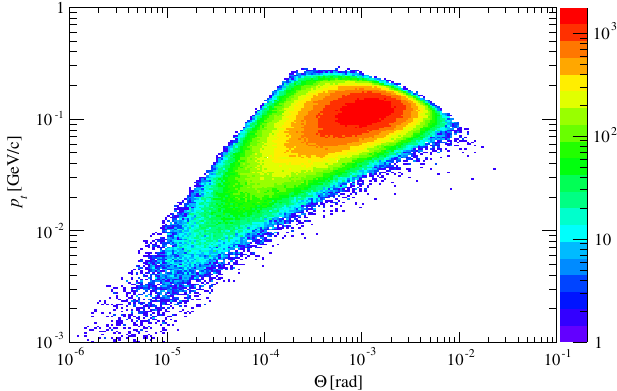
FIG. 11. Distribution of same-charge (defocused) direct tridents after one bunch crossing using the 3 TeV CLIC baseline design parameters. On the z axis is the number of particles in each bin, per bunch crossing. May be compared with the distribution of coherent pairs shown in Figs. 3 and 4.